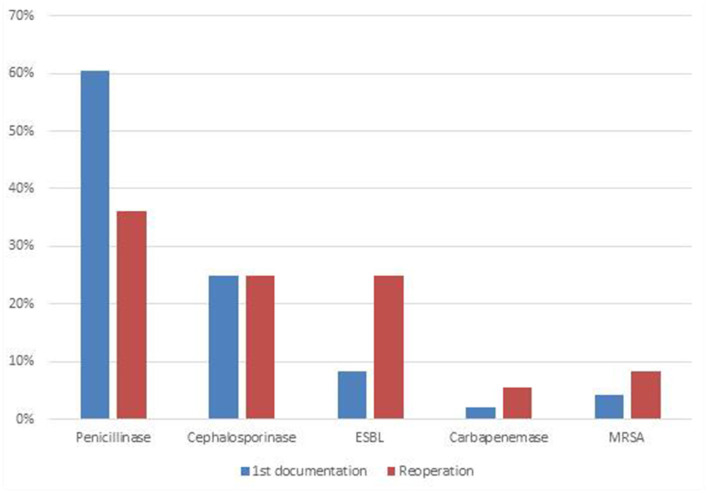
Proportions of identified antibiotic resistances among MDR bacteria during initial surgery and at the time of reoperation. ESBL, extended-spectrum betalactamase; MRSA, methicillin-resistant Staphylococcus aureus.